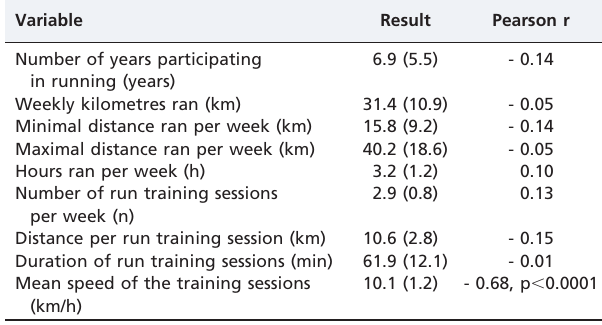
Table 1 - Association of age and anthropometric variables with race time (n= 42).